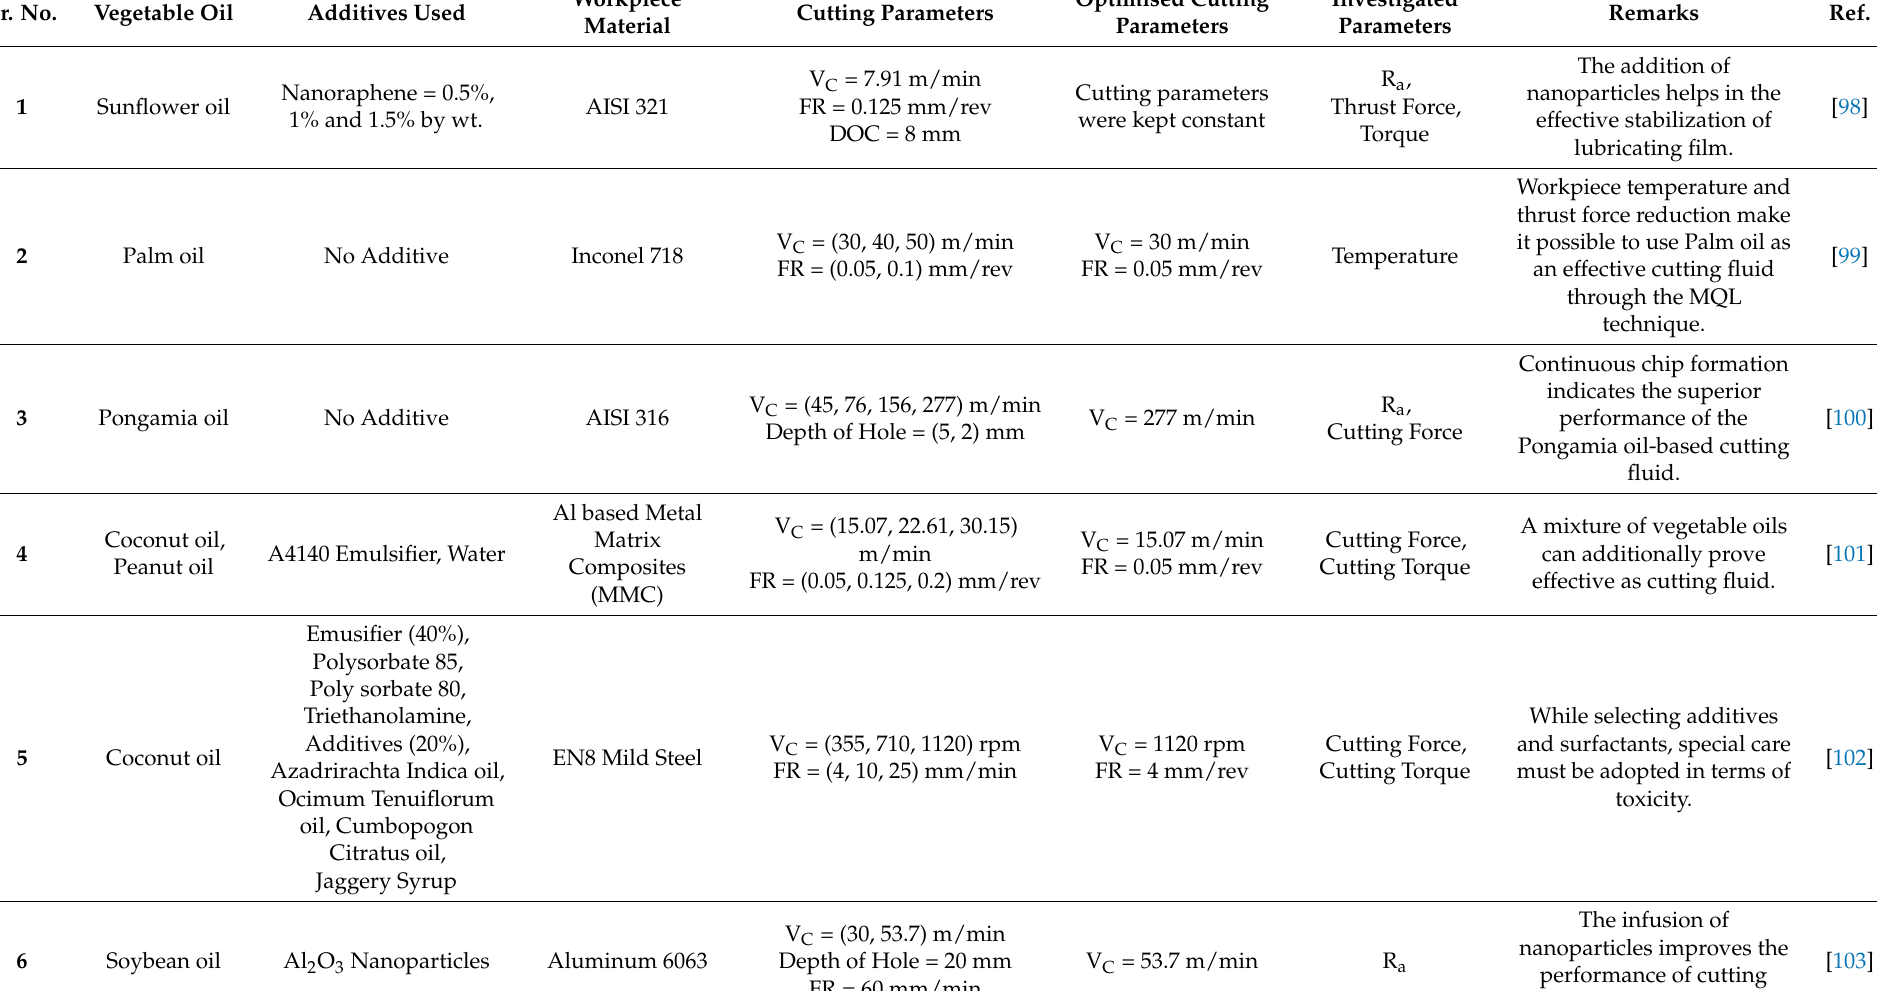
Table 3. Drilling Operation Using Edible Vegetable Oil-Based Cutting